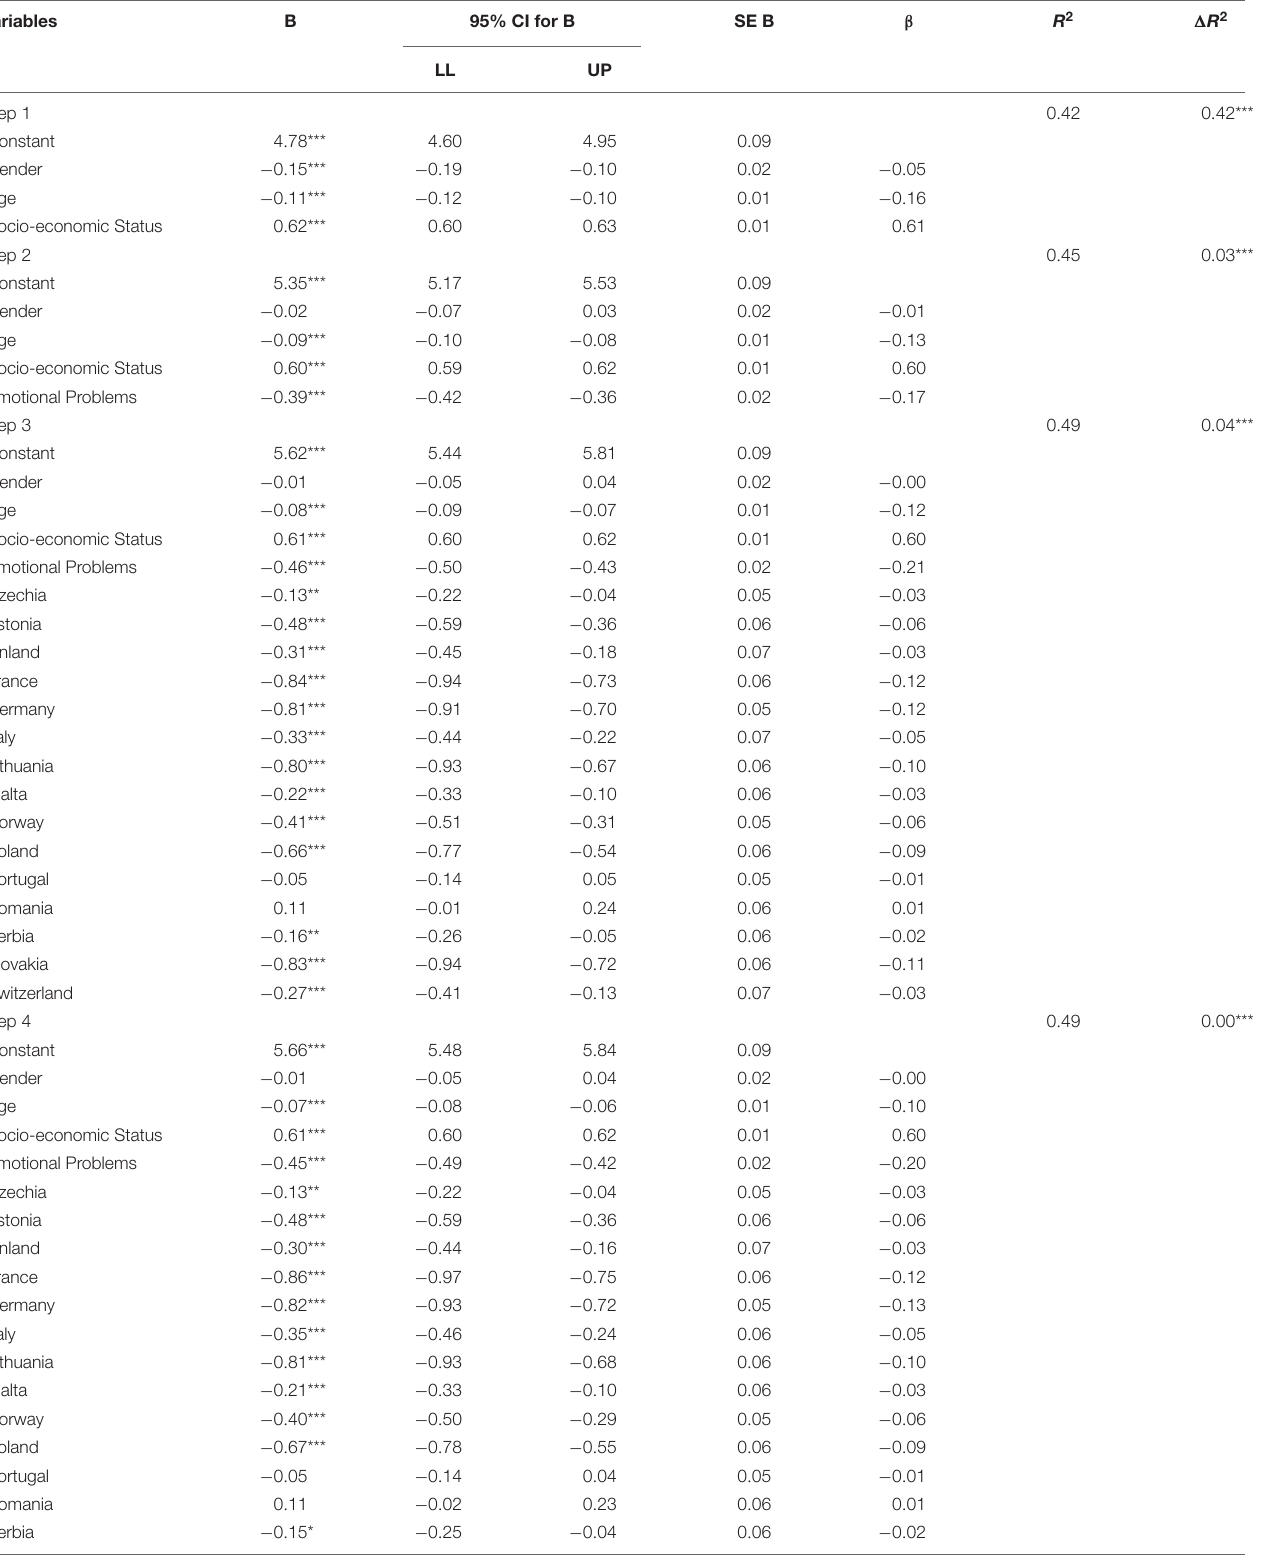
TABLE 3 | Hierarchical multiple regression results for predictors of children’s perceived life